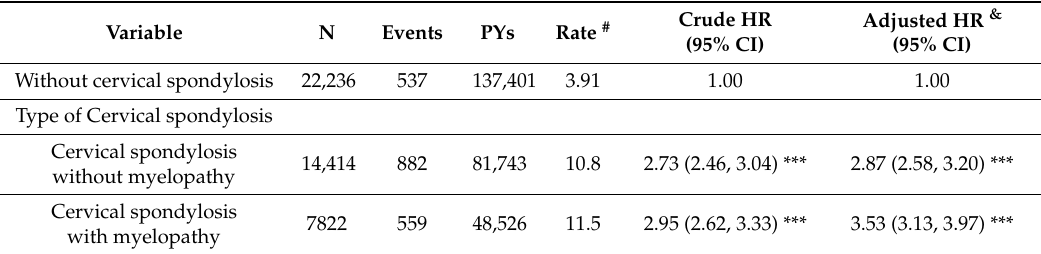
Crude HR Adjusted HR & (95% CI) (95% CI)